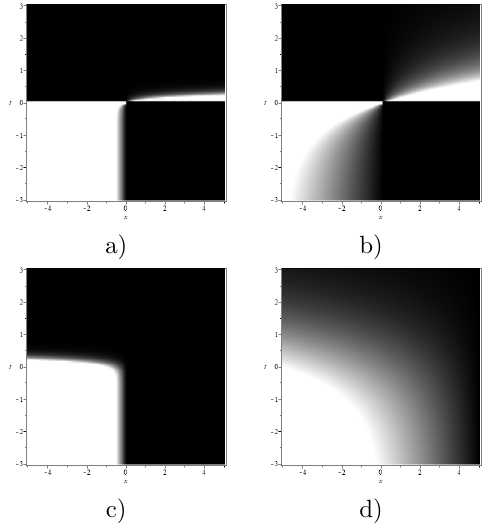
Figure 1. Analytical solutions of (3.3) are presented, we select the parameter values: a) A 2 = 0 . 01 , σ = 10 , ε = +1, b) A 2 = 0 . 1 , σ = 1 , ε = +1, c) A 2 = 0 . 01 , σ = 10 , ε = − 1, d) A 2 = 5 , σ = 1 , ε = −